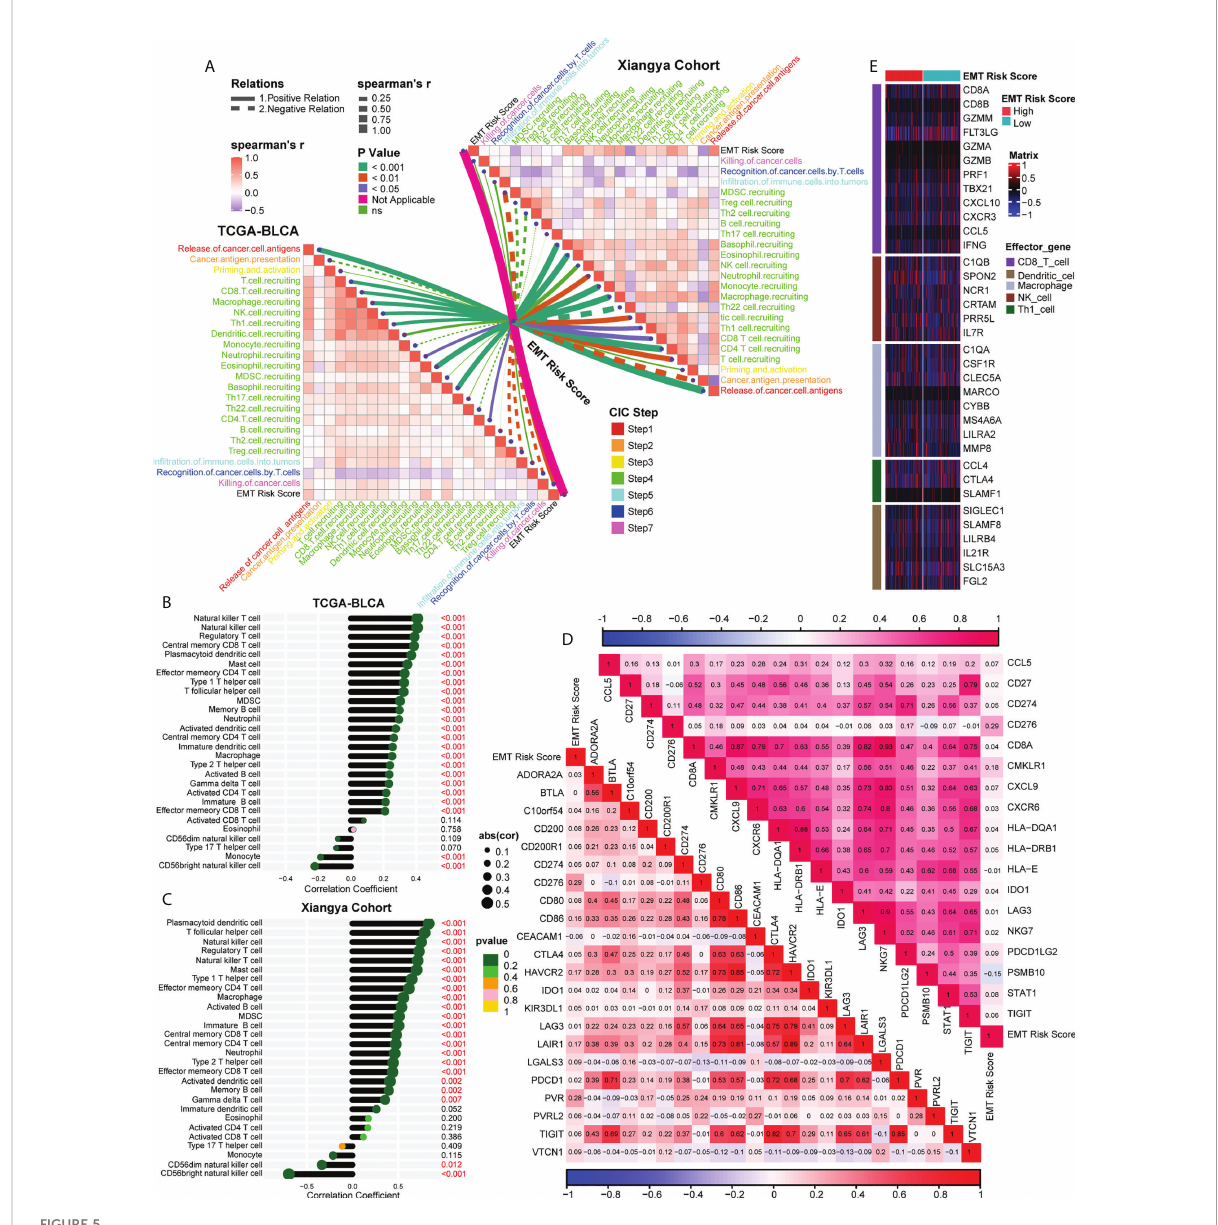
FIGURE 5 Association between EMT risk score and TIME in the TCGA-BLCA and Xiangya cohort. (A) The association between EMT risk score and cancer immunity cycles in the TCGA-BLCA (left) and Xiangya cohort (right). The different types of lines represented the positive or negative relations; The different colors of the lines represented the p values of the relations, and the thickness of the lines represented the strength of the relations. (B, C) The association between EMT risk score and immune cells in the TME in the TCGA-BLCA and Xiangya cohort. (D) The association between EMT risk score and immune checkpoint inhibitor (ICI) genes (down) and T cell-associated in fl ammatory signature (TIS) genes (up), separately. (E) The different expression patterns of effector genes of immune cells between different EMT risk score